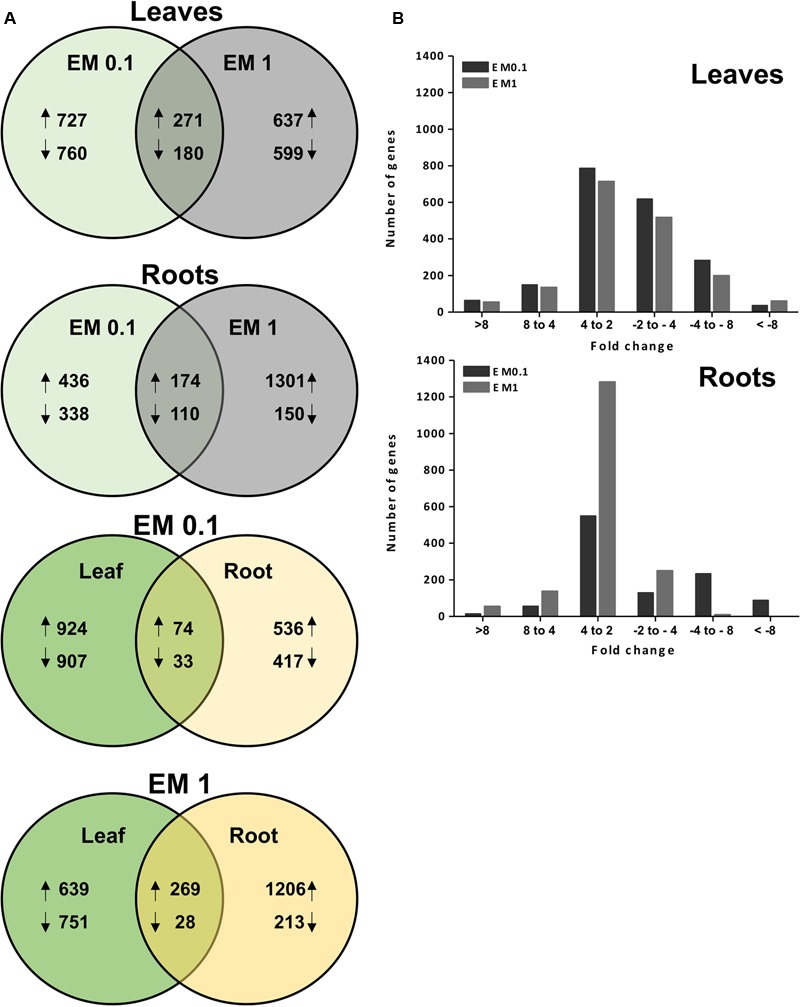
(A) Venn diagram analysis for the EM-responsive genes under the different EM treatments in leaves and roots of S. lycopersicon. Overlapping circles visually represent the commonalities among sets of information. In the first two upper diagrams, arrows upward and downward indicate up-regulation and down-regulation, respectively, compared to the control (no EM treatment). The number of differentially expressed (DEGs) relative to a specific ET treatment (EM at 0.1 mL L-1 or EM 1 mL L-1) is displayed in the non-overlapping regions of the circles. In the lower two diagrams, the number of sequences commonly or individually up-regulated or down-regulated in leaves and roots at a specific EM dosage (B). Distribution of DEGs in leaves and roots of S. lycopersicon based on fold-changes values. The positive and negative numbers on the x-axis represented up- and down-regulation of S. lycopersicon genes, respectively.